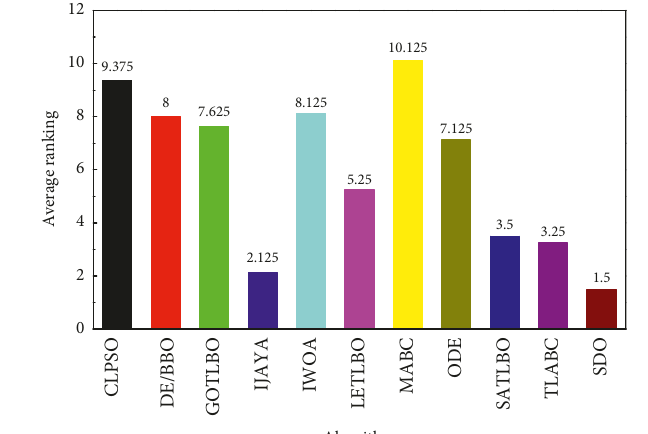
Figure 13: Friedman test result.